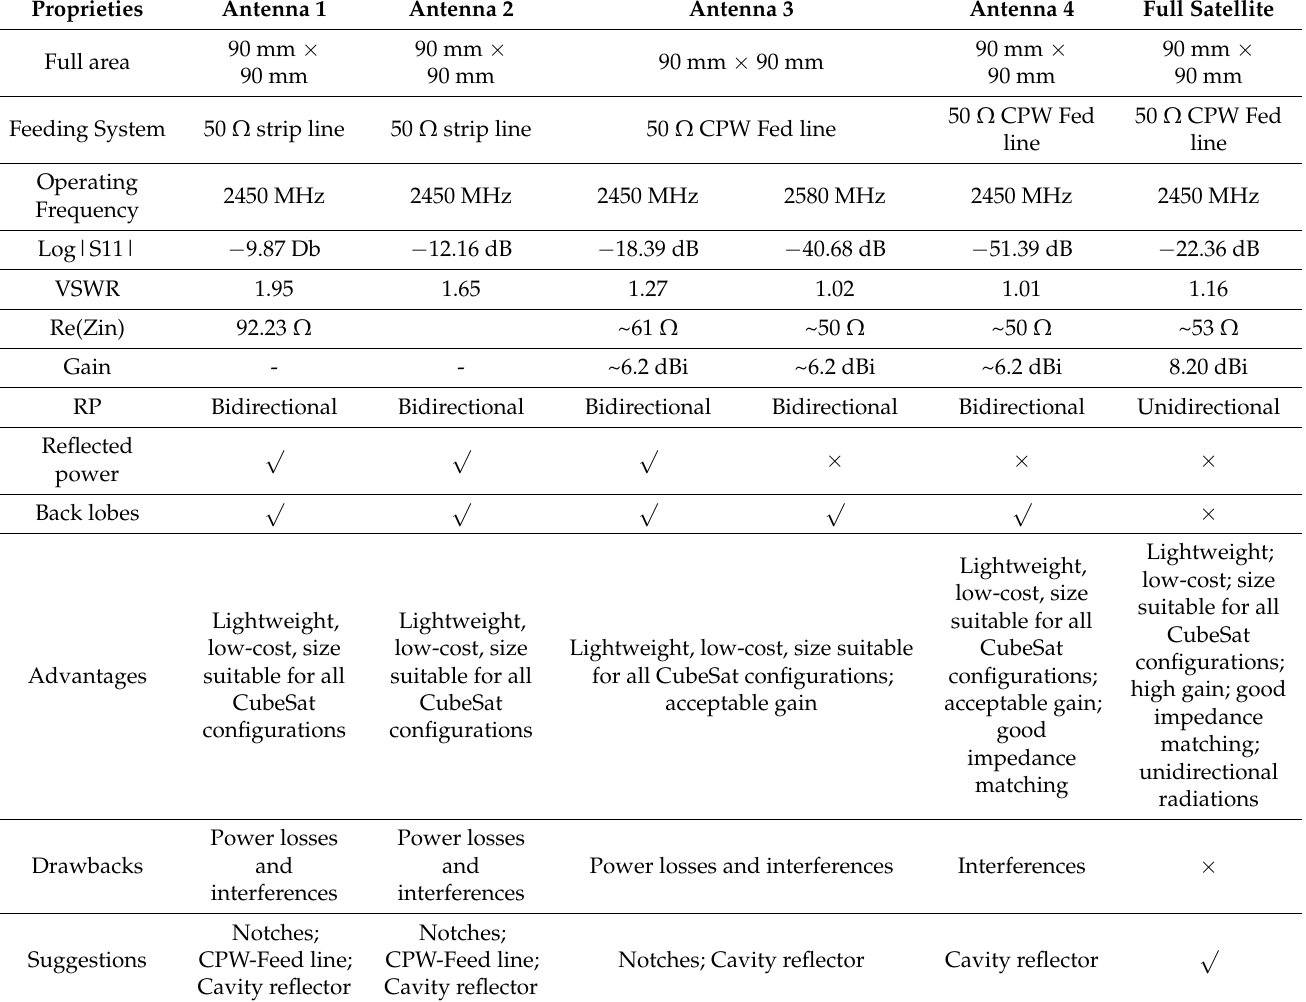
Table 6. Brief summary of antenna performances of all proposed antenna